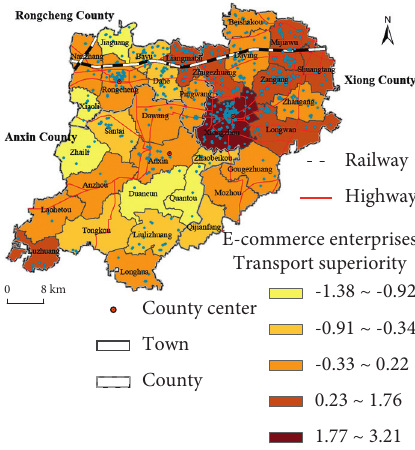
Figure 6: Distribution of transport superiority in Xiong’an New Area.